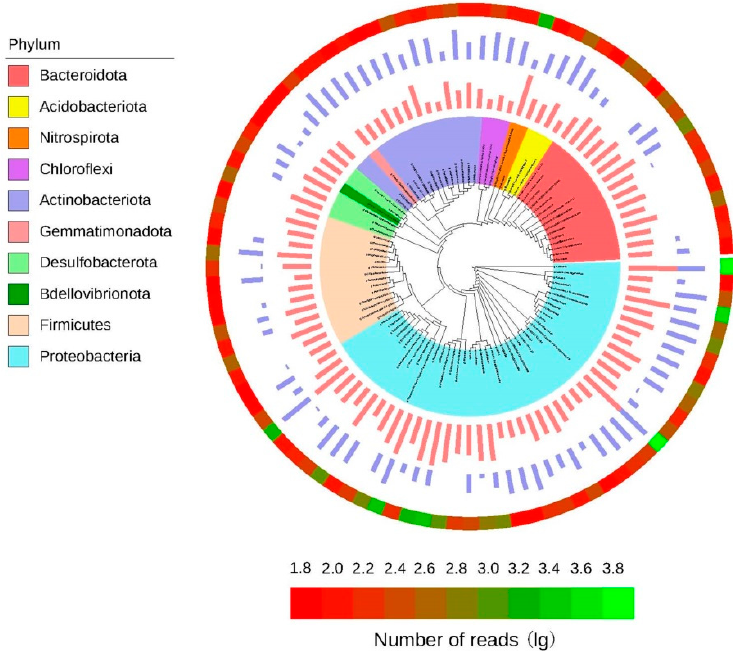
Figure 5. Phylogenetic characteristics of the endosphere and rhizosphere bacterial communities of C . communis (results visualized using iTOL tool). The phylogenetic tree is presented at the genus level and colored by phylum. The length of each bar represents the normalized mean relative abundance of a genus; a red bar indicates endosphere samples, and a purple bar indicates rhizosphere samples. Heat map displays the sum read numbers of all samples for each genus. Data were transformed using the natural logarithm (log10).